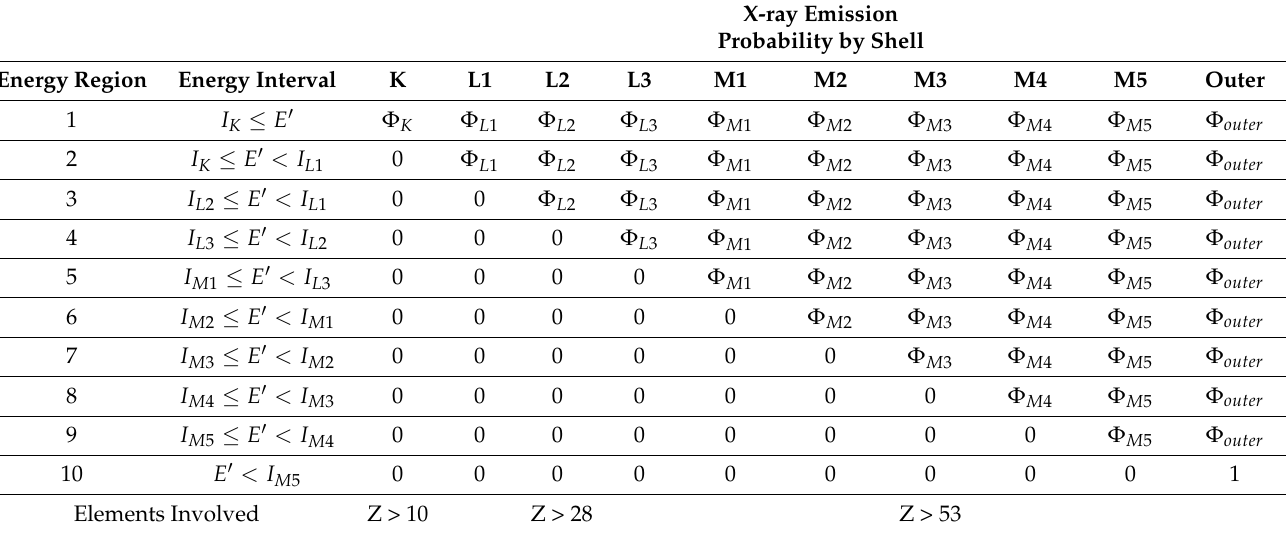
Table A2. Single-shell probabilities of interaction according to the excitation energy. The probabilities are always computed with the Formulas (A1)–(A10).